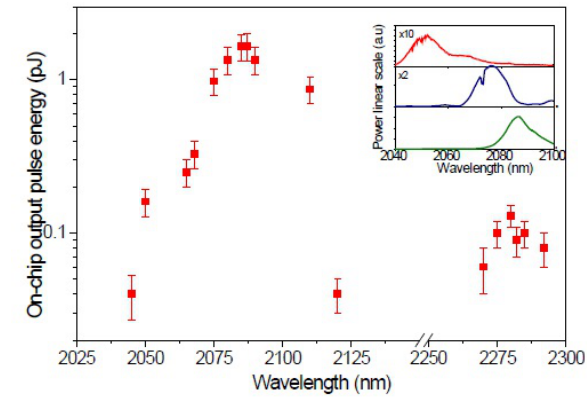
Fig. 25. The output power of our OPO, as shown in the inset of Fig. 24 at different idler wavelengths. Adapted from reference